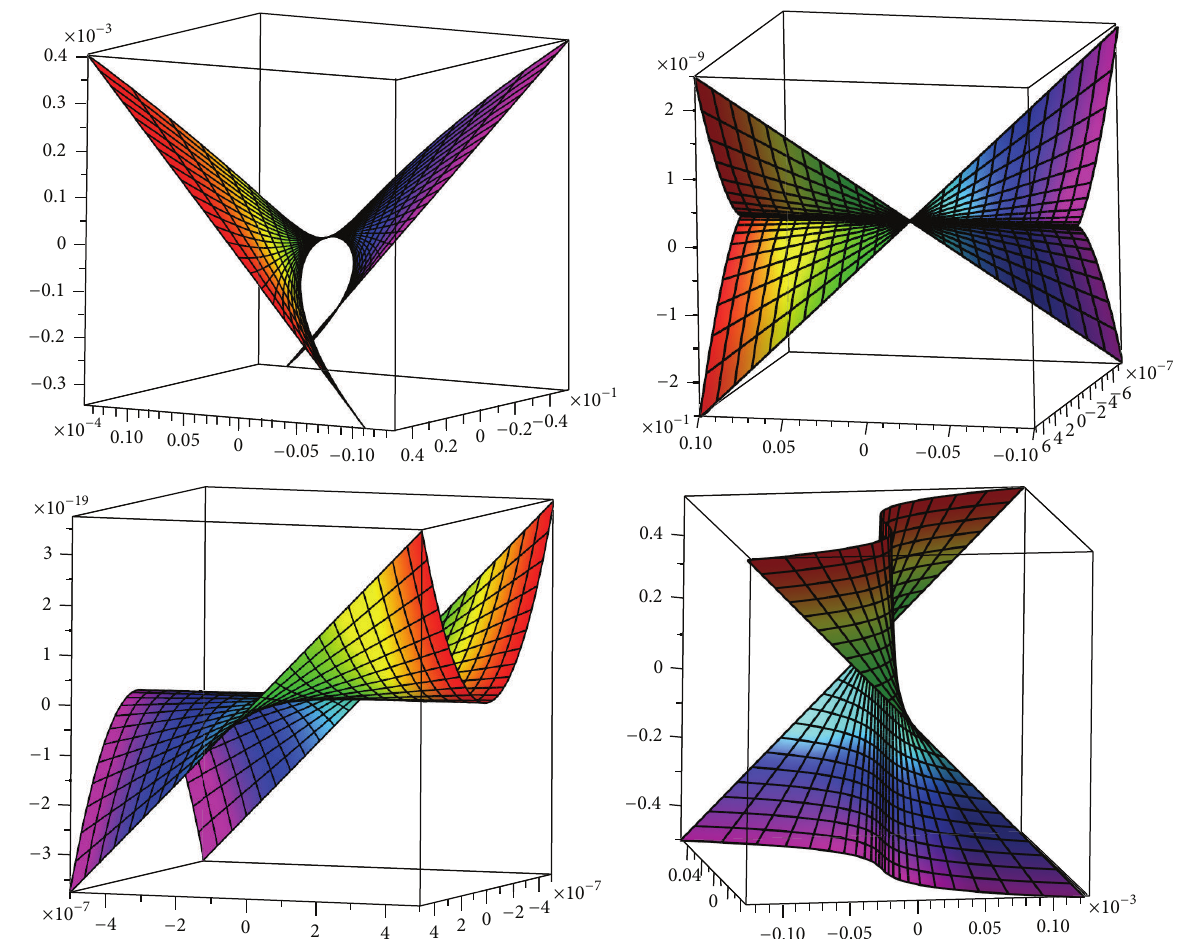
Figure 3: When 𝑤 = 0 , projection of a butterfly, respectively, on 𝑥 1 𝑥 2 𝑥 3 -space, 𝑥 1 𝑥 2 𝑥 4 -space, 𝑥 1 𝑥 3 𝑥 4 -space, and 𝑥 2 𝑥 3 𝑥 4